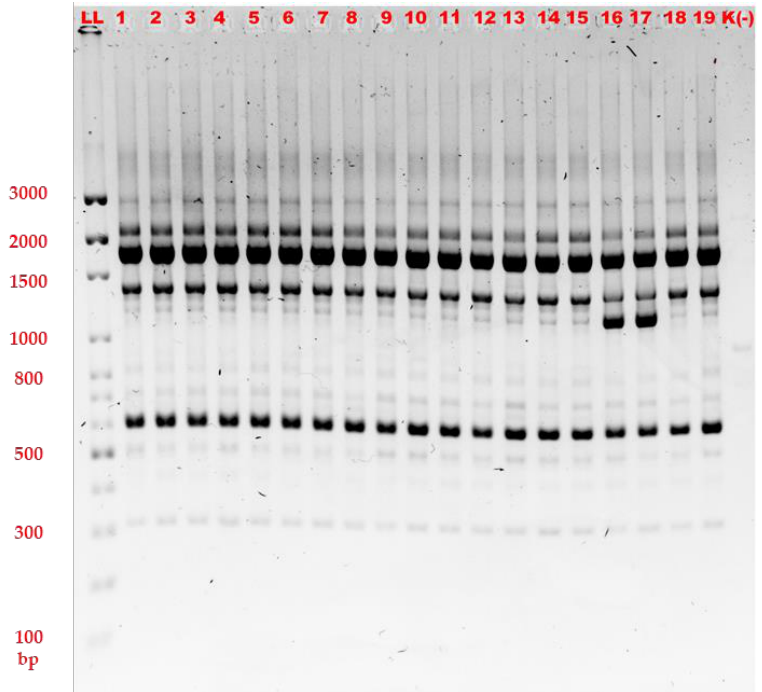
Figure 1. Agarose gel electrophoresis of RAPD-PCR amplification products with AP5 primer, 9 V/cm, 90 min, 1.5% agarose (1 – 19 — numbers of the strains, K( − ) — negative control, LL — DNA size marker 100 — 3000 bp).